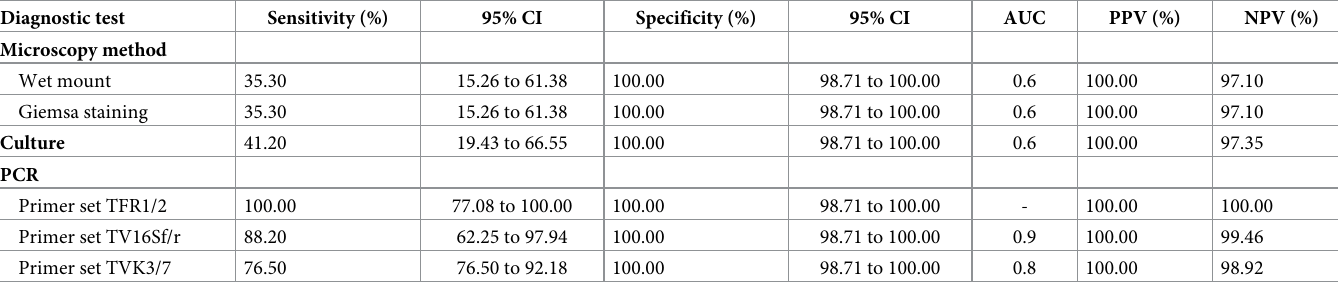
Table 4. Performance of each diagnostic test compared to the expandard gold standard.